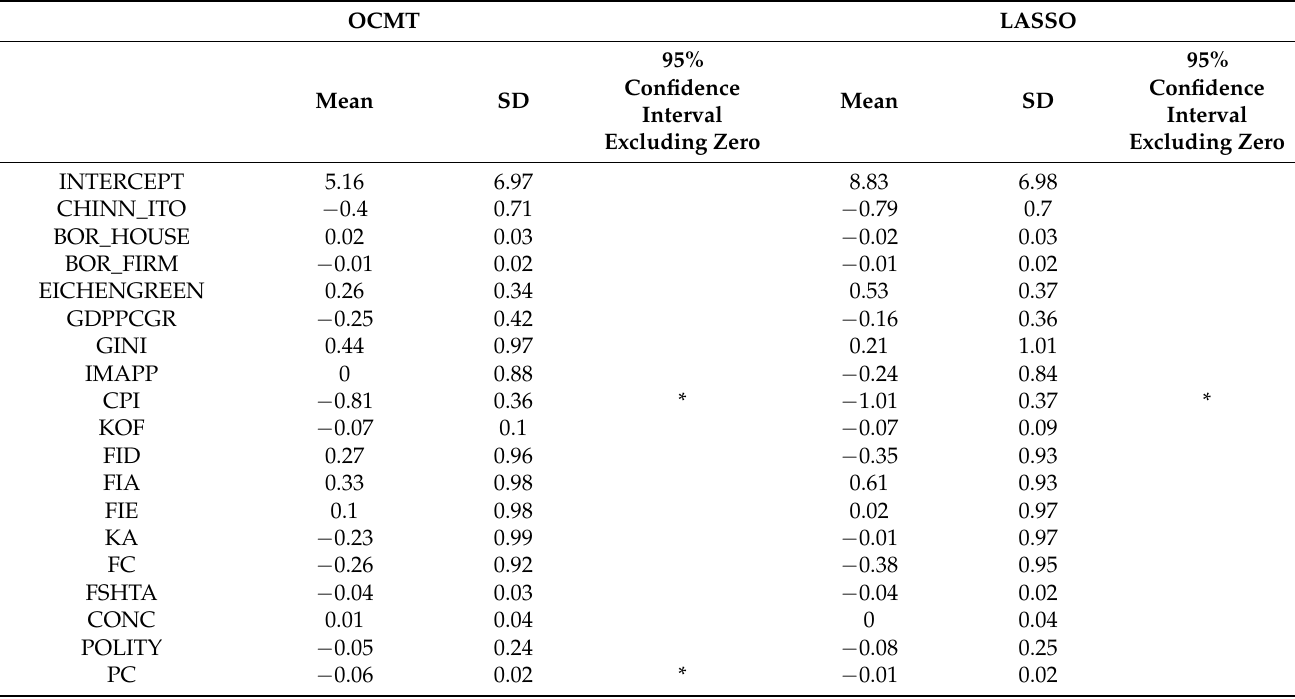
Table 8. Results for the Bayesian logit model for